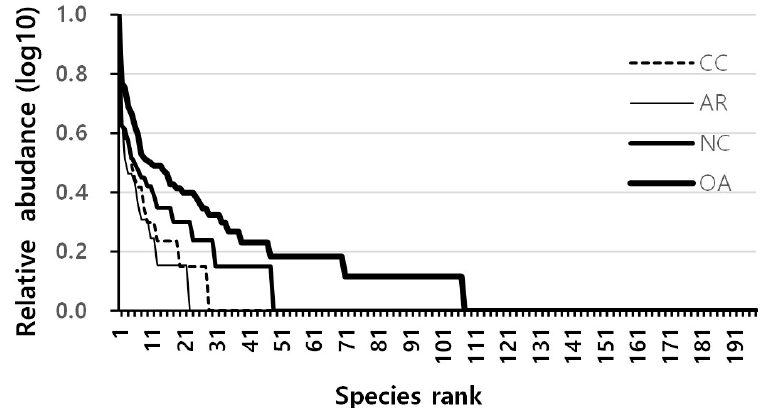
Figure 2. Species rank abundance curve of moths collected from four different treatment stands. CC: clearcutting area; AR: aggregated retention area; NC: no cutting area; OA: Mongolian oak area.